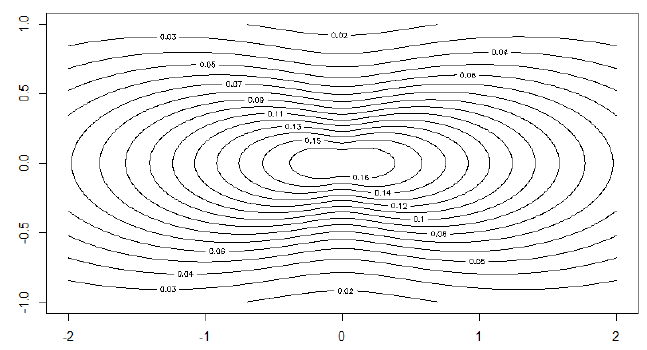
Figure 2. Plot of the boundaries of K in the cases a = 10 (solid line), a = 3 (dashed line), a = 1 (dotted line) and a = 0.3 (dashed/dotted line).